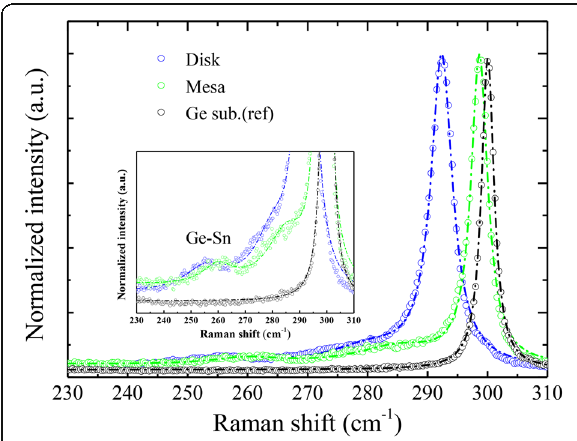
Fig. 6 Comparison of the Raman spectra of the 5 μ m Ge 0.902 Sn 0.098 microdisk with 300 nm diameter Ge pedestal, 5 μ m Ge 0.902 Sn 0.098 diameter mesa and a bulk Ge substrate as a reference. Inset: enlarged view of the Raman spectra. The Ge-Sn peaks can also be observed around 260 cm − 1 , and down shift with decreasing the diameter of Ge